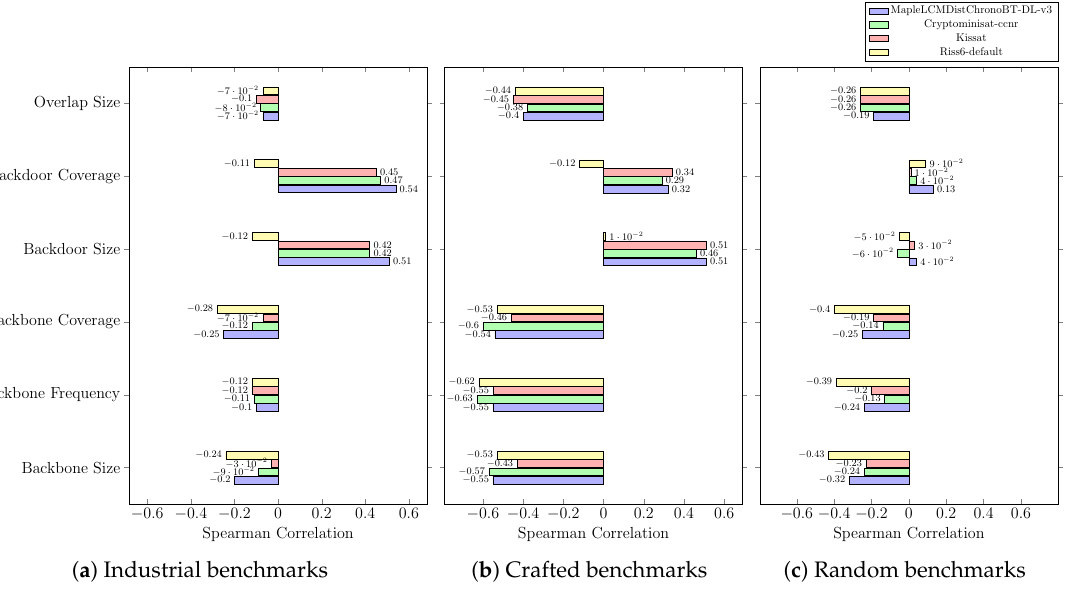
Figure A4. Spearman correlation results between Boolean structural measures and the CPU time on 2002–2020 SAT benchmark instances.